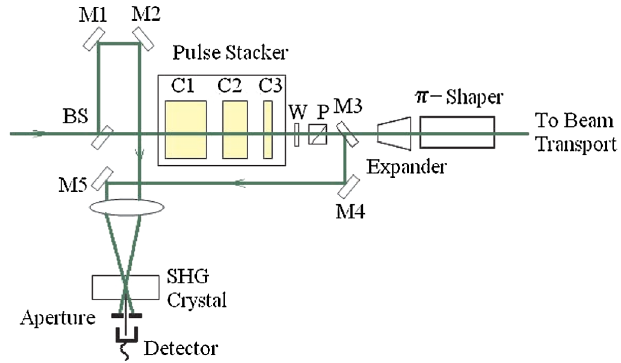
FIG. 2. (Color) Schematic of the experimental setup and the cross correlator. The beam splitter BS, mirror M3, wave plate W, and polarizer P are mounted on flip